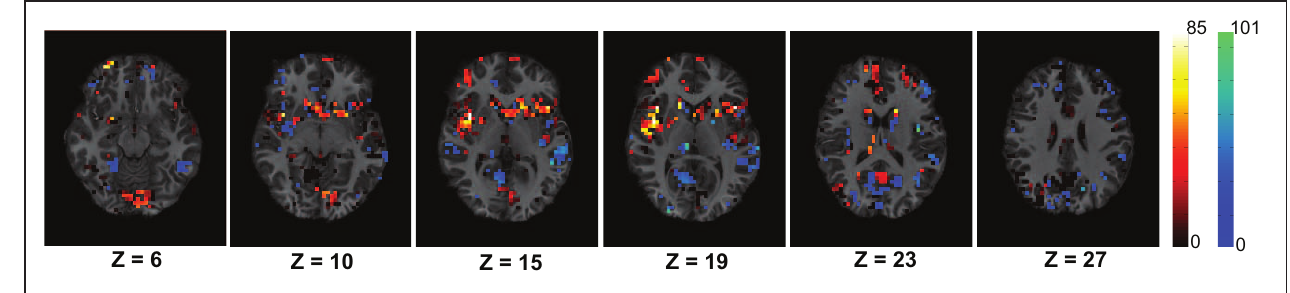
FIGURE 6 | The figure shows average difference of degrees of the control group from the ADHD group for the voxels within the useful region mask. The average difference is calculated using the 83 subjects of KKI training set. The dark red to white color map is used to represents higher